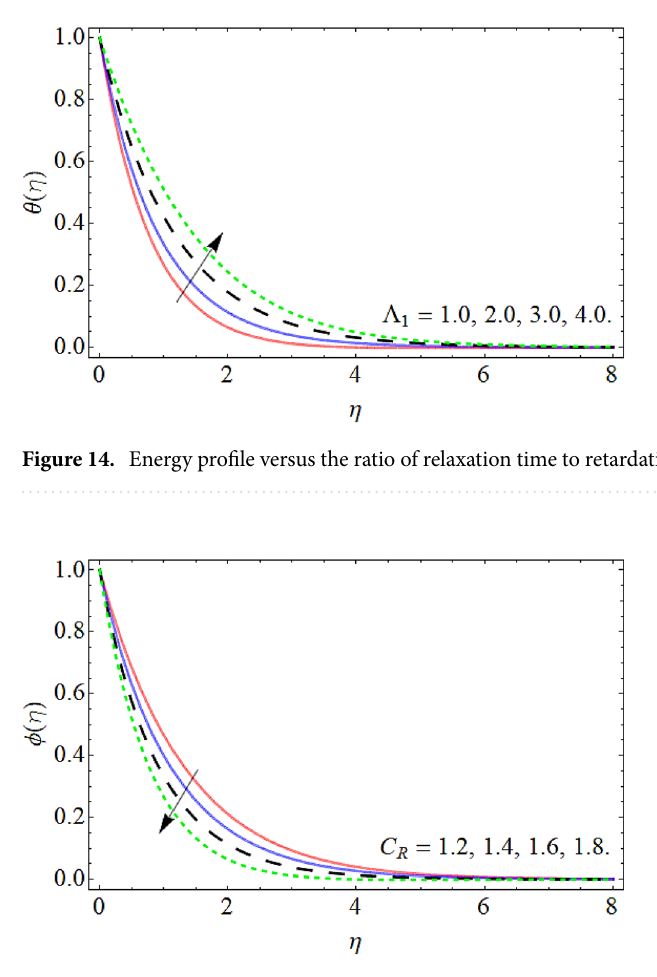
Figure 15. Mass profile versus the chemical reaction C R .